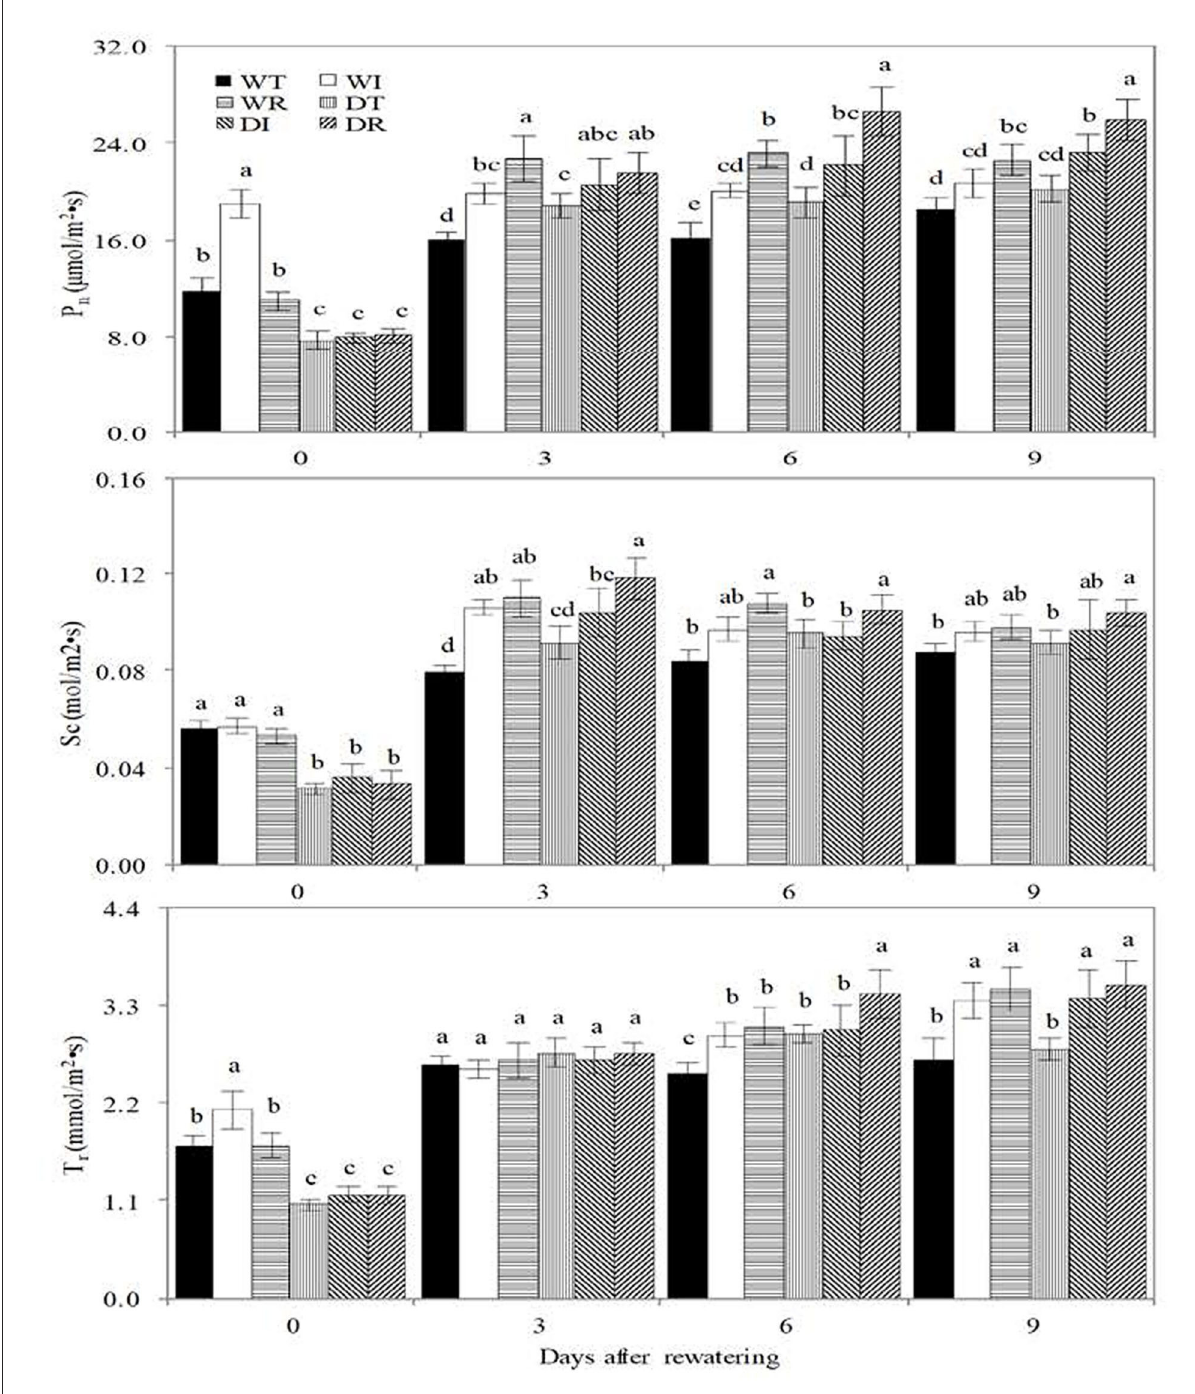
FIGURE5 Biomass, water use efficiency in the different treatments in the study. WT, WI, WR, DT, DI, and DR indicate treatments of wetness, wetness with AOB strain inoculation during wet period, wetness with AOB strain inoculation during rewatering period, post-drought rewatering, post-drought rewatering with AOB strain inoculation during wet period, post-drought rewatering with AOB strain inoculation during rewatering period, respectively. In “0”, “3”, “6” and “9” respectively stand for the beginning, 3rd day, 6th day, 9th day of the 9-day rewatering period. Pn, Sc, and Tr represent the net photosynthetic rate, conductance, and transpiration rate, respectively. The values are the mean ± standard error ( n = 3). The different letters in each row indicate significant differences ( P <